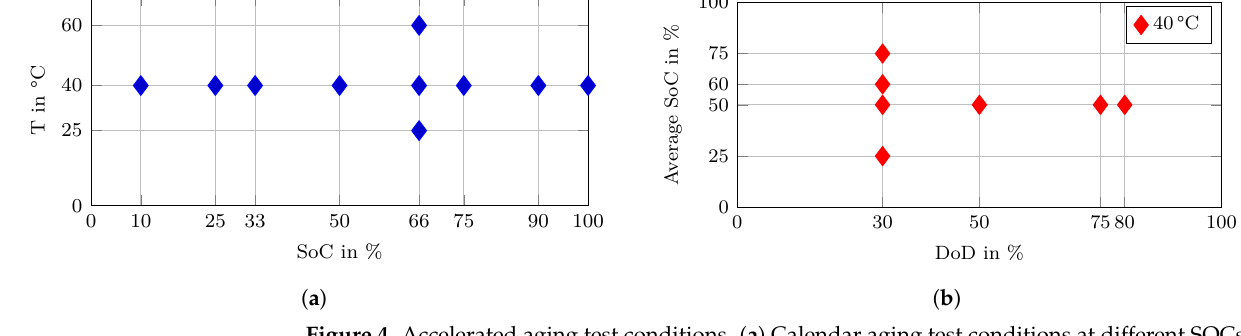
Figure 4. Accelerated aging test conditions. ( a ) Calendar aging test conditions at different SOCs and temperatures; ( b ) Cycle aging test conditions at different average SOCs and DoDs. All cycle aging tests were carried out at